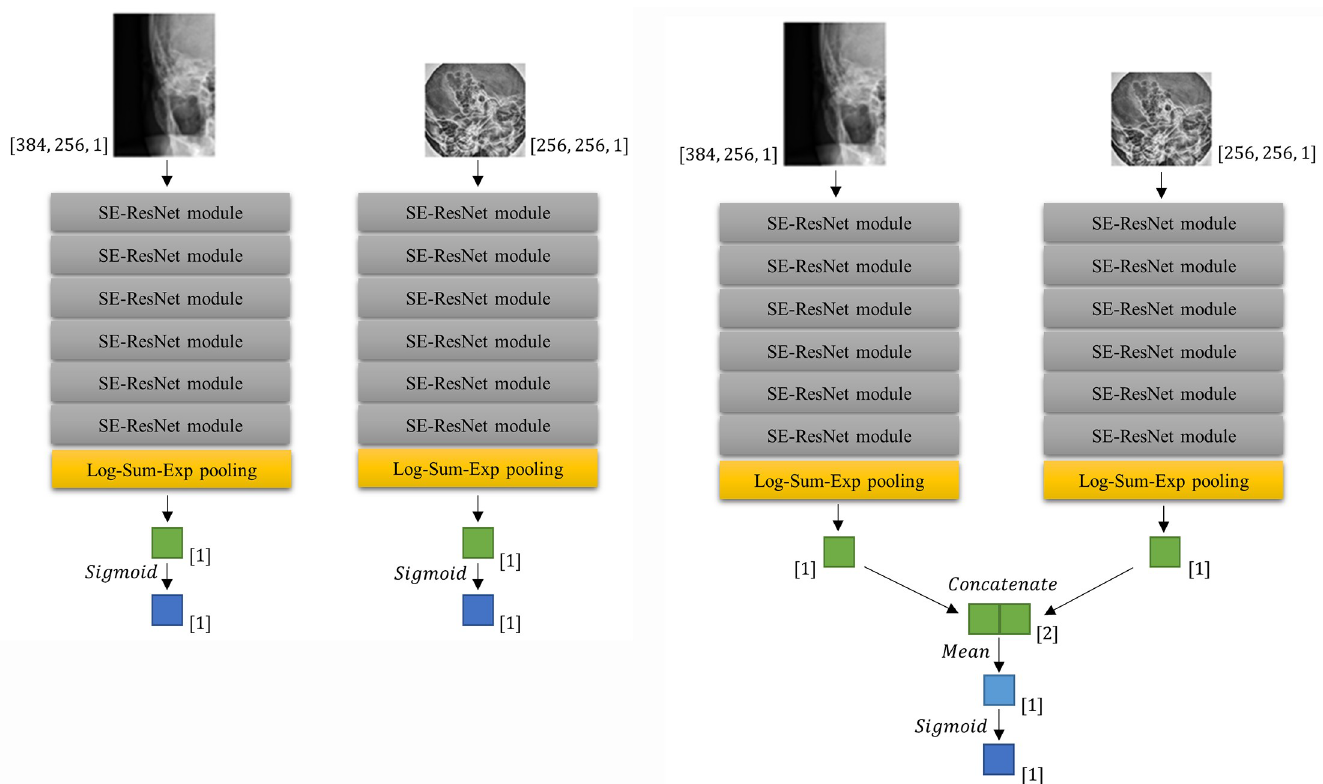
Fig 3. Network architectures for predicting mastoiditis. The CNNs (convolutional neural networks) for single view (a) show a process in which AP and lateral views are separately trained in CNN. The CNN for multiple views (b) shows a process in which AP and lateral views are simultaneously trained. After Log-Sum-Exp pooling, the layers were also marked with dimensions. [1] means 1 × 1 size vector, and [2] means 1 × 2 size vector.